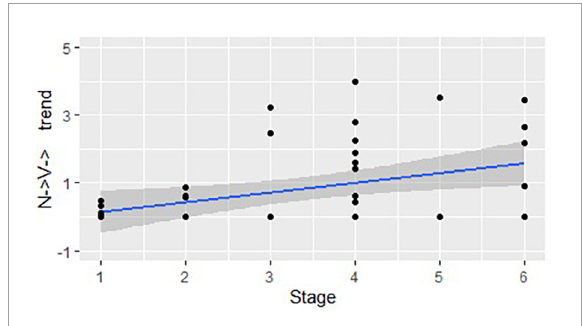
FIGURE3 The developmental trend in structures that start as a noun and change their class more than once: correlation between the stages of linguistic development and the mean number of structures used in each DCP (represented by dots), per 100 utterances.